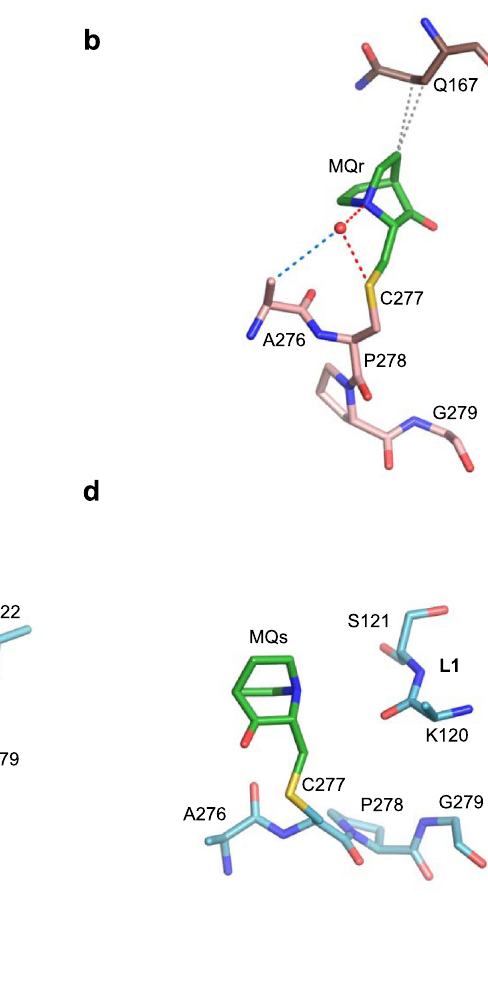
R273C/S240R-DNA-MQ, and wt-DNA-MQ (I, II, III). In addition,